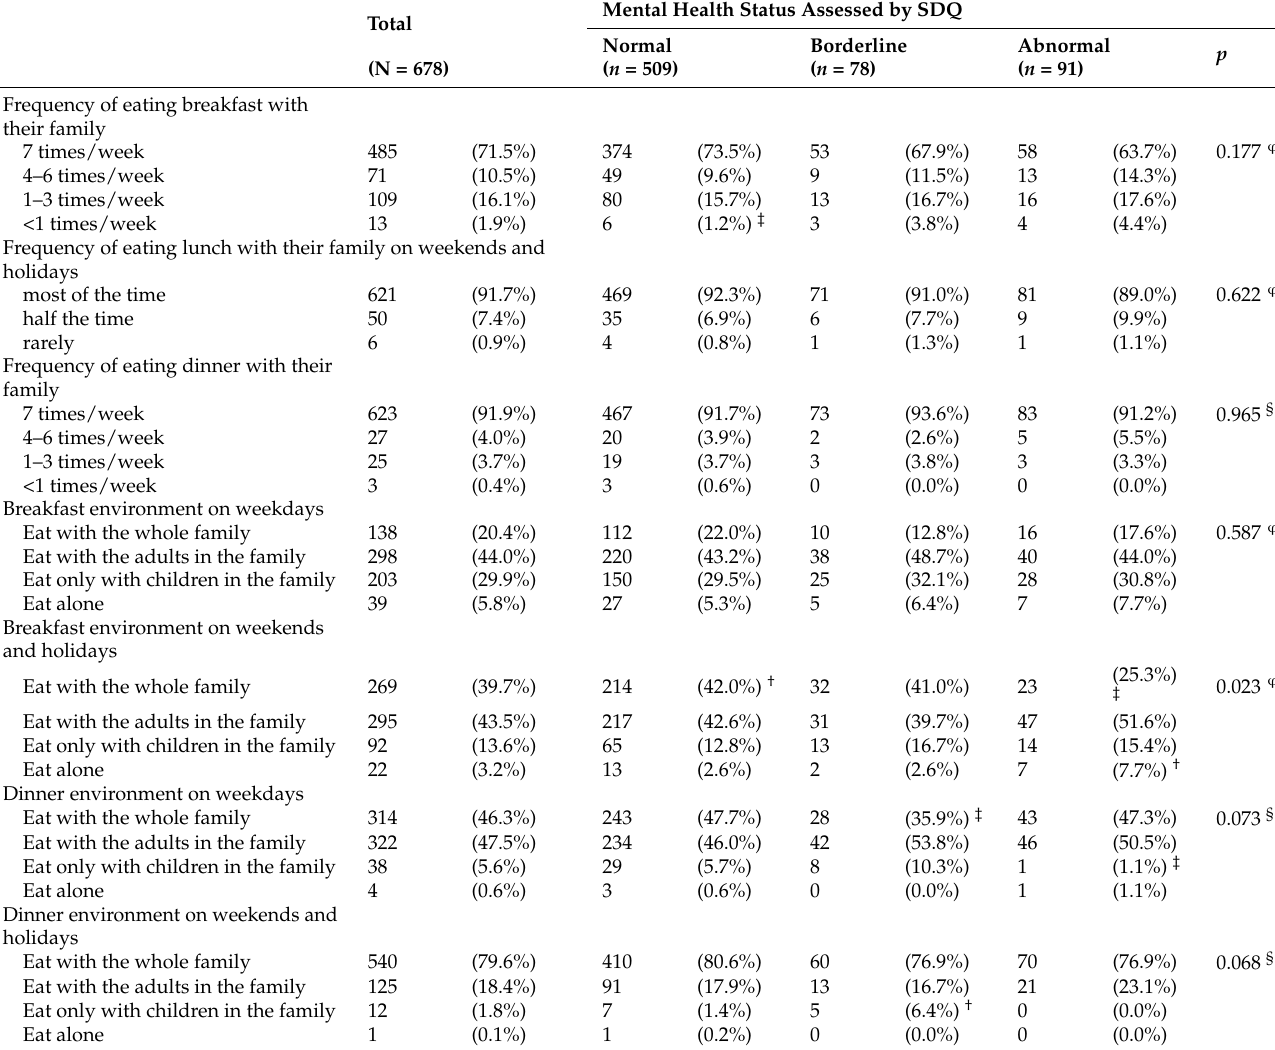
Table 2. Family meal frequency and mealtime environment for Japanese elementary schoolchildren according to the classification of mental health status assessed by the Strengths and Difficulties Questionnaire (N =